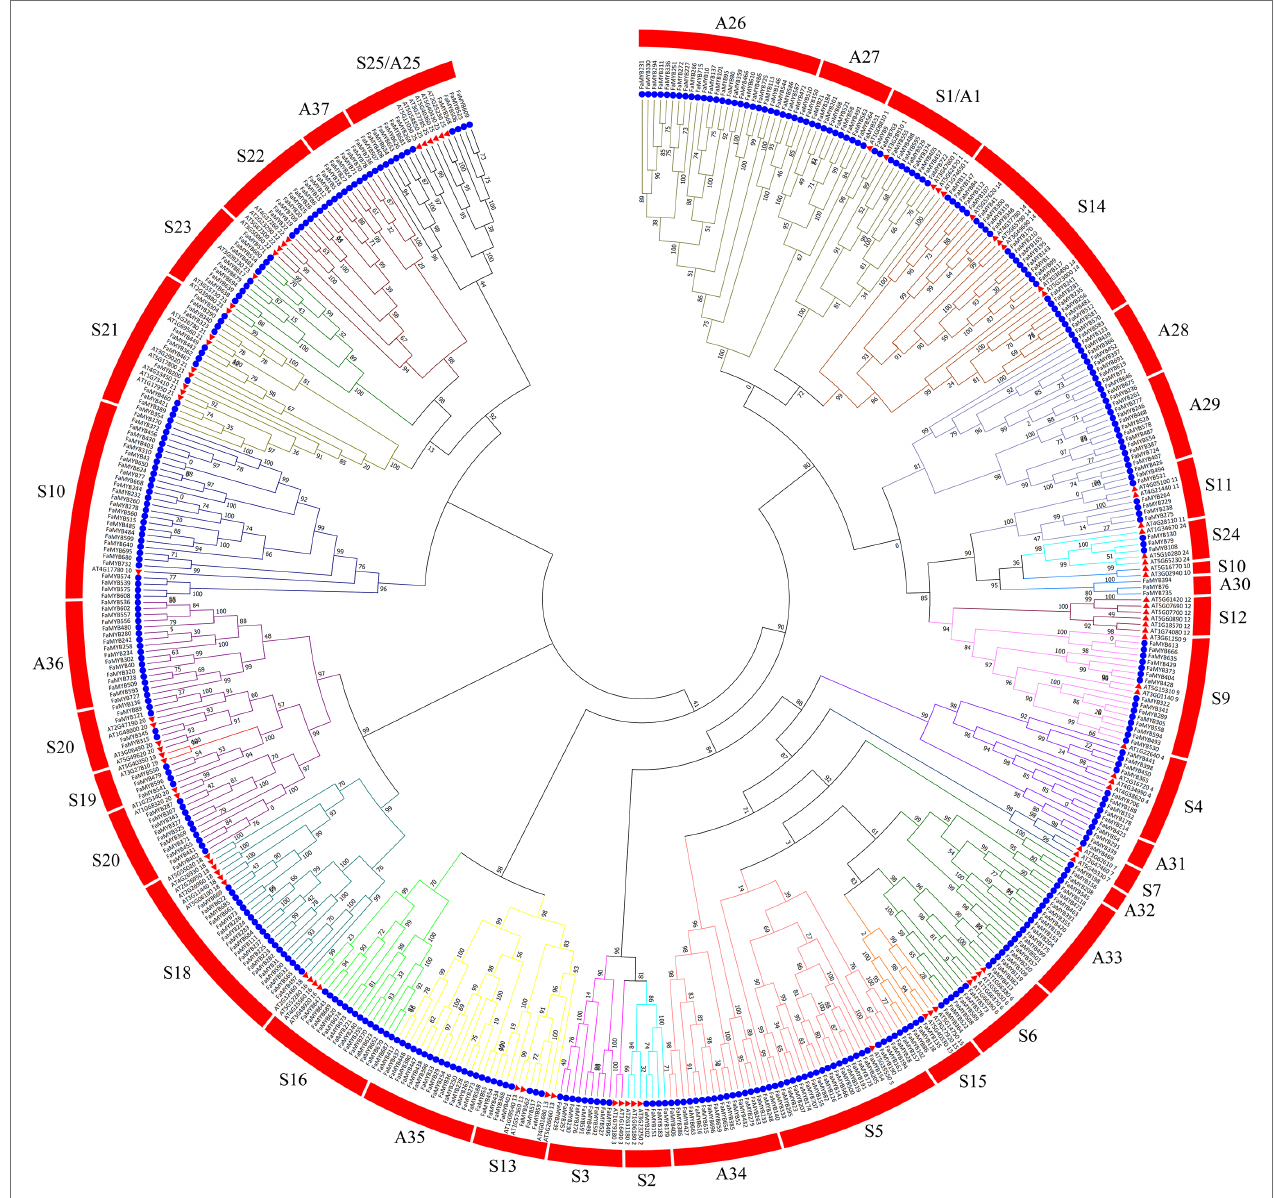
FIGURE 2 | Phylogenetic relationships of R2R3-MYB proteins between F. × ananassa and Arabidopsis . The circles and triangles represented genes from F. × ananassa and Arabidopsis , respectively. All 37 subfamilies of R2R3-MYBs were well separated in different clades and represented by different colors. The ML phylogenetic tree was generated using JTT algorithm with 1,000 bootstrap value via MEGA